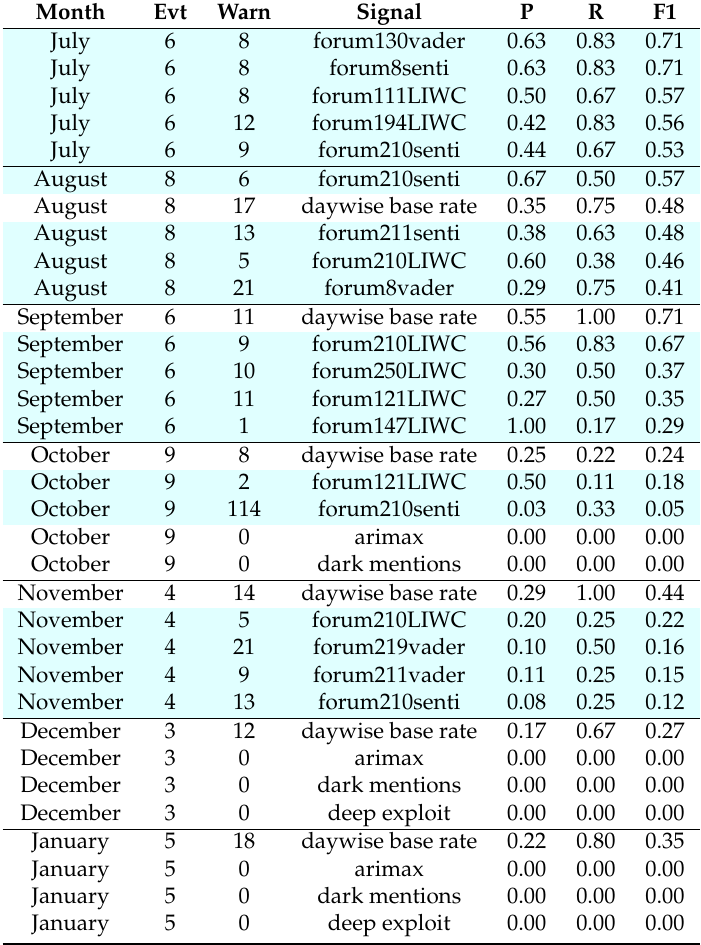
Table A5. Results from Org. B’s Malicious Destination.